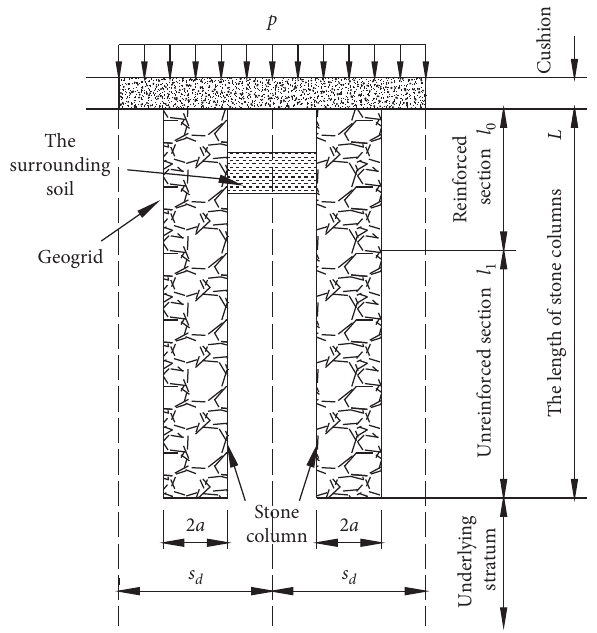
Figure 1: Composition of composite foundation reinforced by geogrid-encased stone